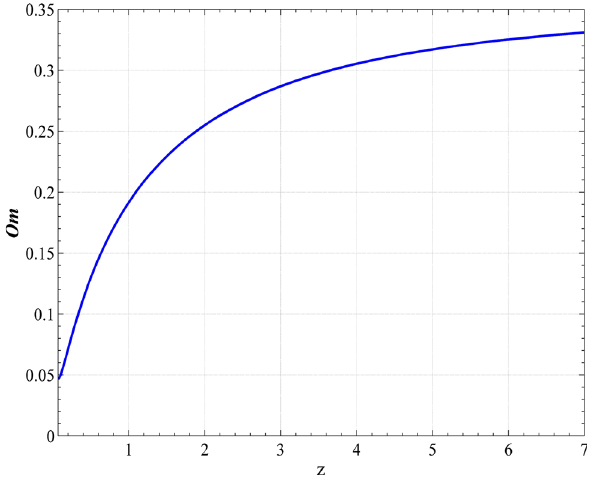
Fig. 5 The plot indicates the Om-diagnostic versus redshift z at the redshift range [0.07 ,